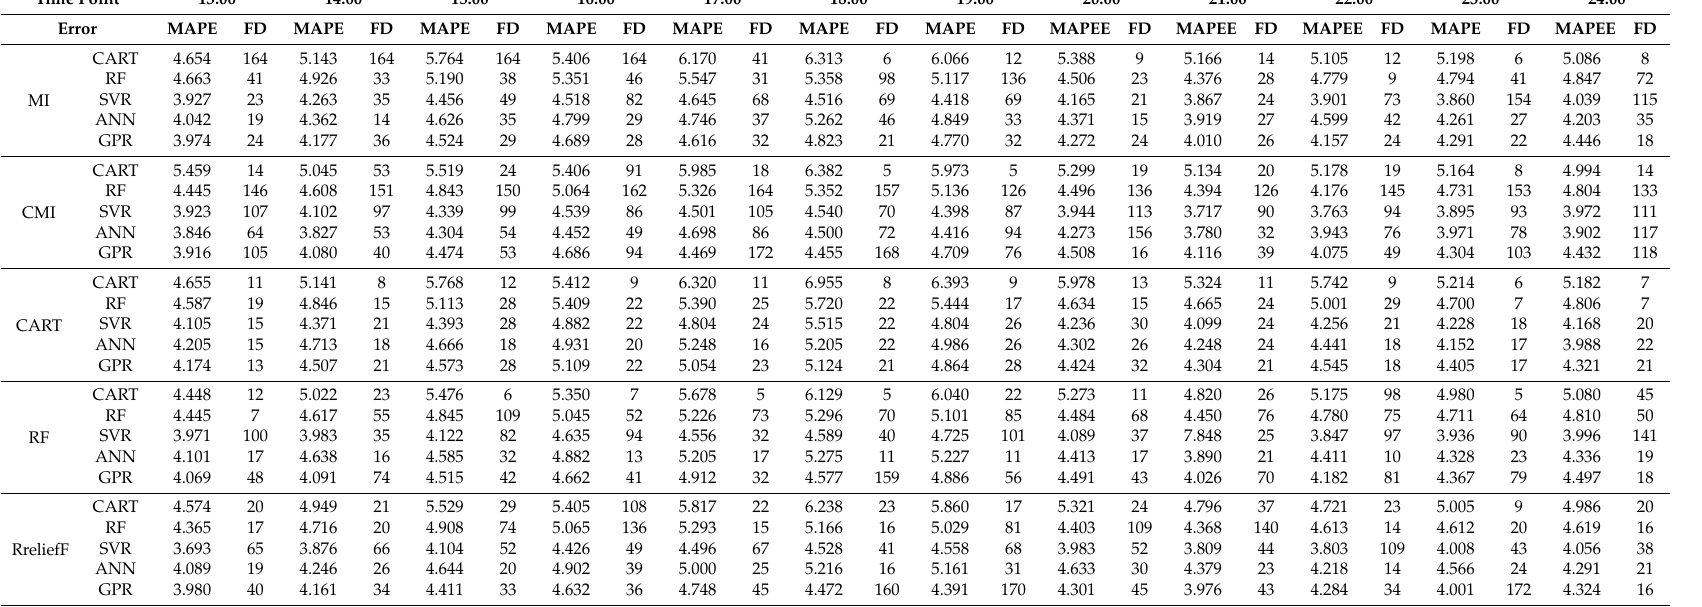
Table A2. Optimal feature subset construction of different hours from 13:00 to 24:00 with different methods for New